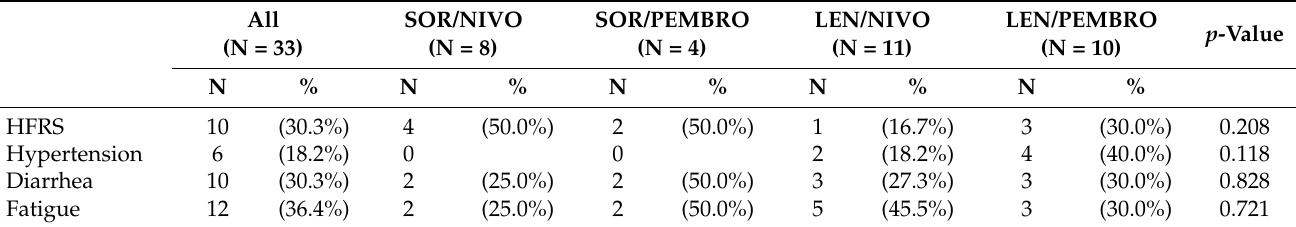
Table 4. Adverse events of combination